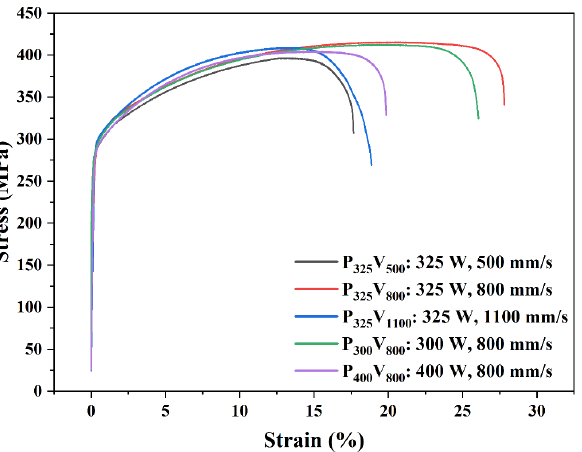
Figure 16. E ff ect of scanning speed (laser power of 325 W) ( a ) and laser power (scanning speed of